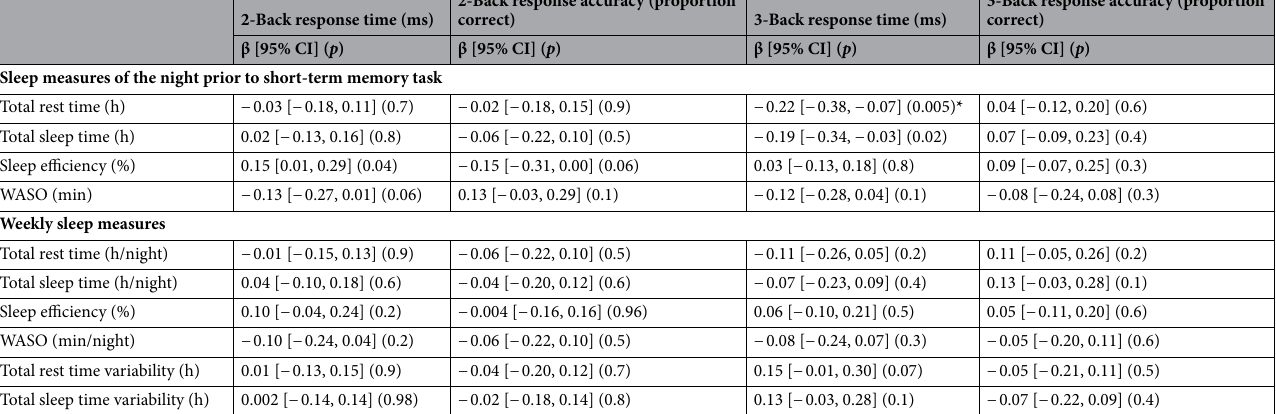
Table 4. Results of linear regression between sleep parameters and response times and accuracies on the short-term working memory task. β, standardized beta value; CI, confidence interval; WASO, wake time after sleep onset. *Significant after Benjamini–Hochberg analysis of all comparisons with 0.25 false discovery rate. All regressions adjusted for clinical diagnosis of attention deficit hyperactivity disorder and reported weekly video game use. 2-back and 3-back response time additionally adjusted for 1-back response times. 2-back and 3-back response accuracy additionally adjusted for 1-back response accuracy. Response times, response accuracies, sleep efficiency, total sleep time variability, and total rest time variability were transformed prior to analysis due to skewed